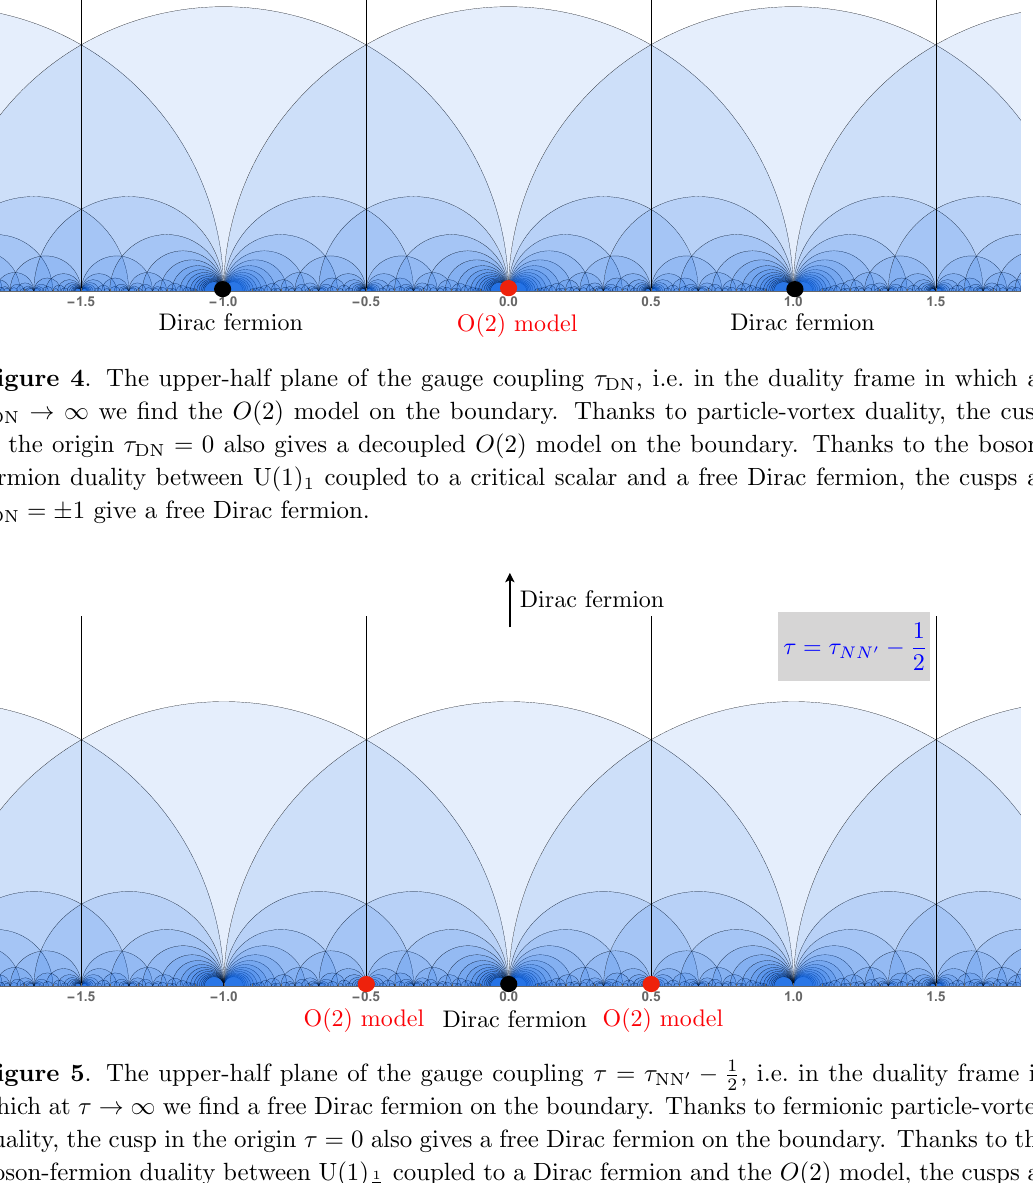
1 Figure 5 . The upper-half plane of the gauge coupling (cid:28) = (cid:28) , i.e. in the duality frame in NN 0 (cid:0) 2 which at (cid:28) we (cid:12)nd a free Dirac fermion on the boundary. Thanks to fermionic particle-vortex ! 1 duality, the cusp in the origin (cid:28) = 0 also gives a free Dirac fermion on the boundary. Thanks to the boson-fermion duality between U(1) 1 coupled to a Dirac fermion and the O (2) model, the cusps at 2 1 (cid:28) = give the O (2) 2 (cid:6)